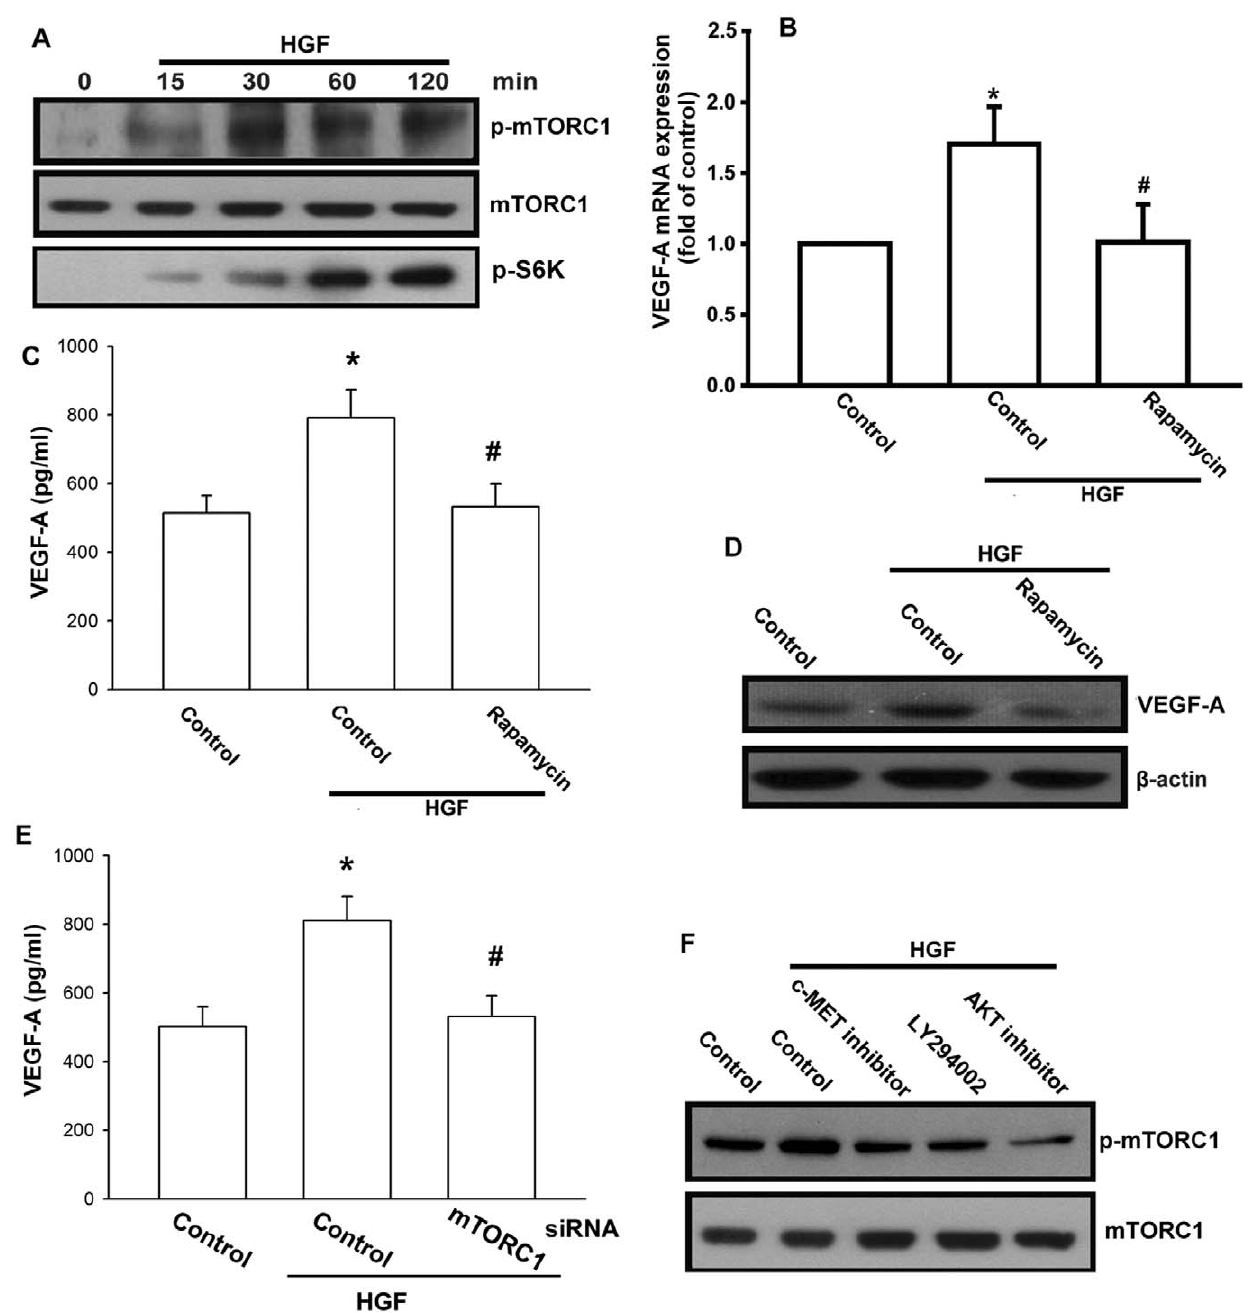
Figure 4. mTORC1 activation is involved in HGF-mediated VEGF-A production. (A) OASFs were incubated with HGF for indicated time intervals, mTORC1 and S6K phosphorylation was examined by Western blotting. (B–D) OASFs were pretreated for 30 min with rapamycin (30 nM) followed by treatment with HGF for 24 h, the VEGF-A expression was examined by qPCR, Western blotting, and ELISA. (E) OASFs were transfected with mTORC1 siRNA followed by stimulation with HGF for 24 h, the VEGF-A expression was examined by ELISA. (F) OASFs were pretreated for 30 min with c-Met inhibitor, Ly294002, and Akt inhibitor for 30 min, followed by stimulation with HGF for 30 min, and mTORC1 phosphorylation was determined by Western blotting. Results are expressed as the mean 6 S.E. *, p , 0.05 compared with control; # , p , 0.05 compared with HGF-treated group. doi:10.1371/journal.pone.0050924.g004 reduced HGF-increased VEGF-A production (Fig. 3B–D). Trans- VEGF-A expression, we next determined Akt Ser 473 phosphory- fection with p85 mutant also reduced HGF-induced VEGF-A lation in response to HGF treatment. As shown in Figure 3A, expression (Fig. 3E). Pretreatment of cells with c-Met inhibitor treatment of OASFs with HGF resulted in time-dependent reduced HGF-mediated p85 phosphorylation (Fig. 3F). To phosphorylation of Akt Ser 473 . Pretreatment of cells with Akt examine the crucial role of PI3K-dependent Akt in HGF-induced inhibitor or transfection of cells with Akt mutant antagonized